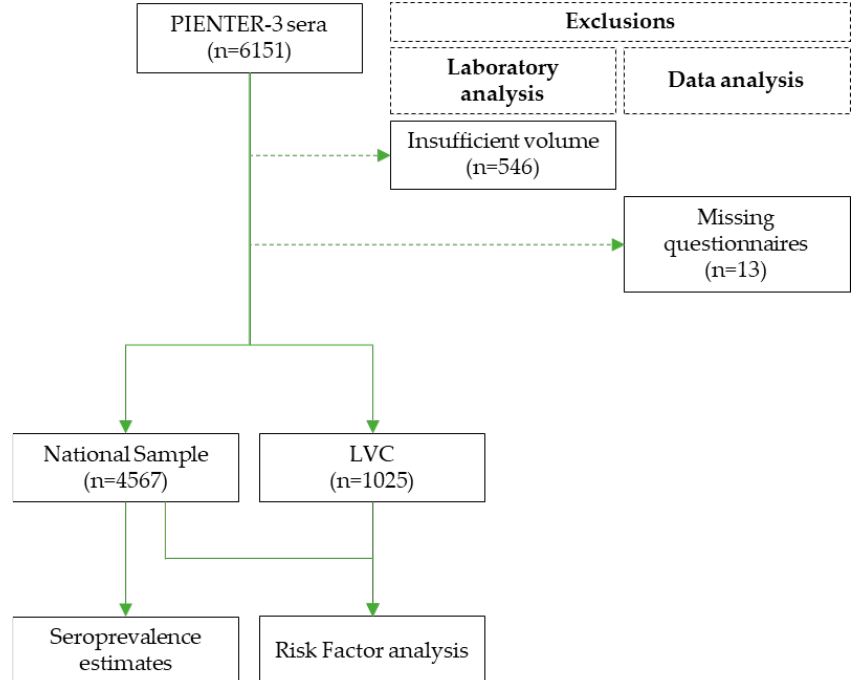
Figure 1. A flow chart of the study setup. The national sample and the Low Vaccination Coverage sample (LVC) of the PIENTER-3 biobank [9] were used to study the seroprevalence and risk factors of Lyme borreliosis in the Netherlands in 2016–2017. The national sample was used for seroprevalence estimates. Both the national sample and the LVC were used for risk factor analysis.